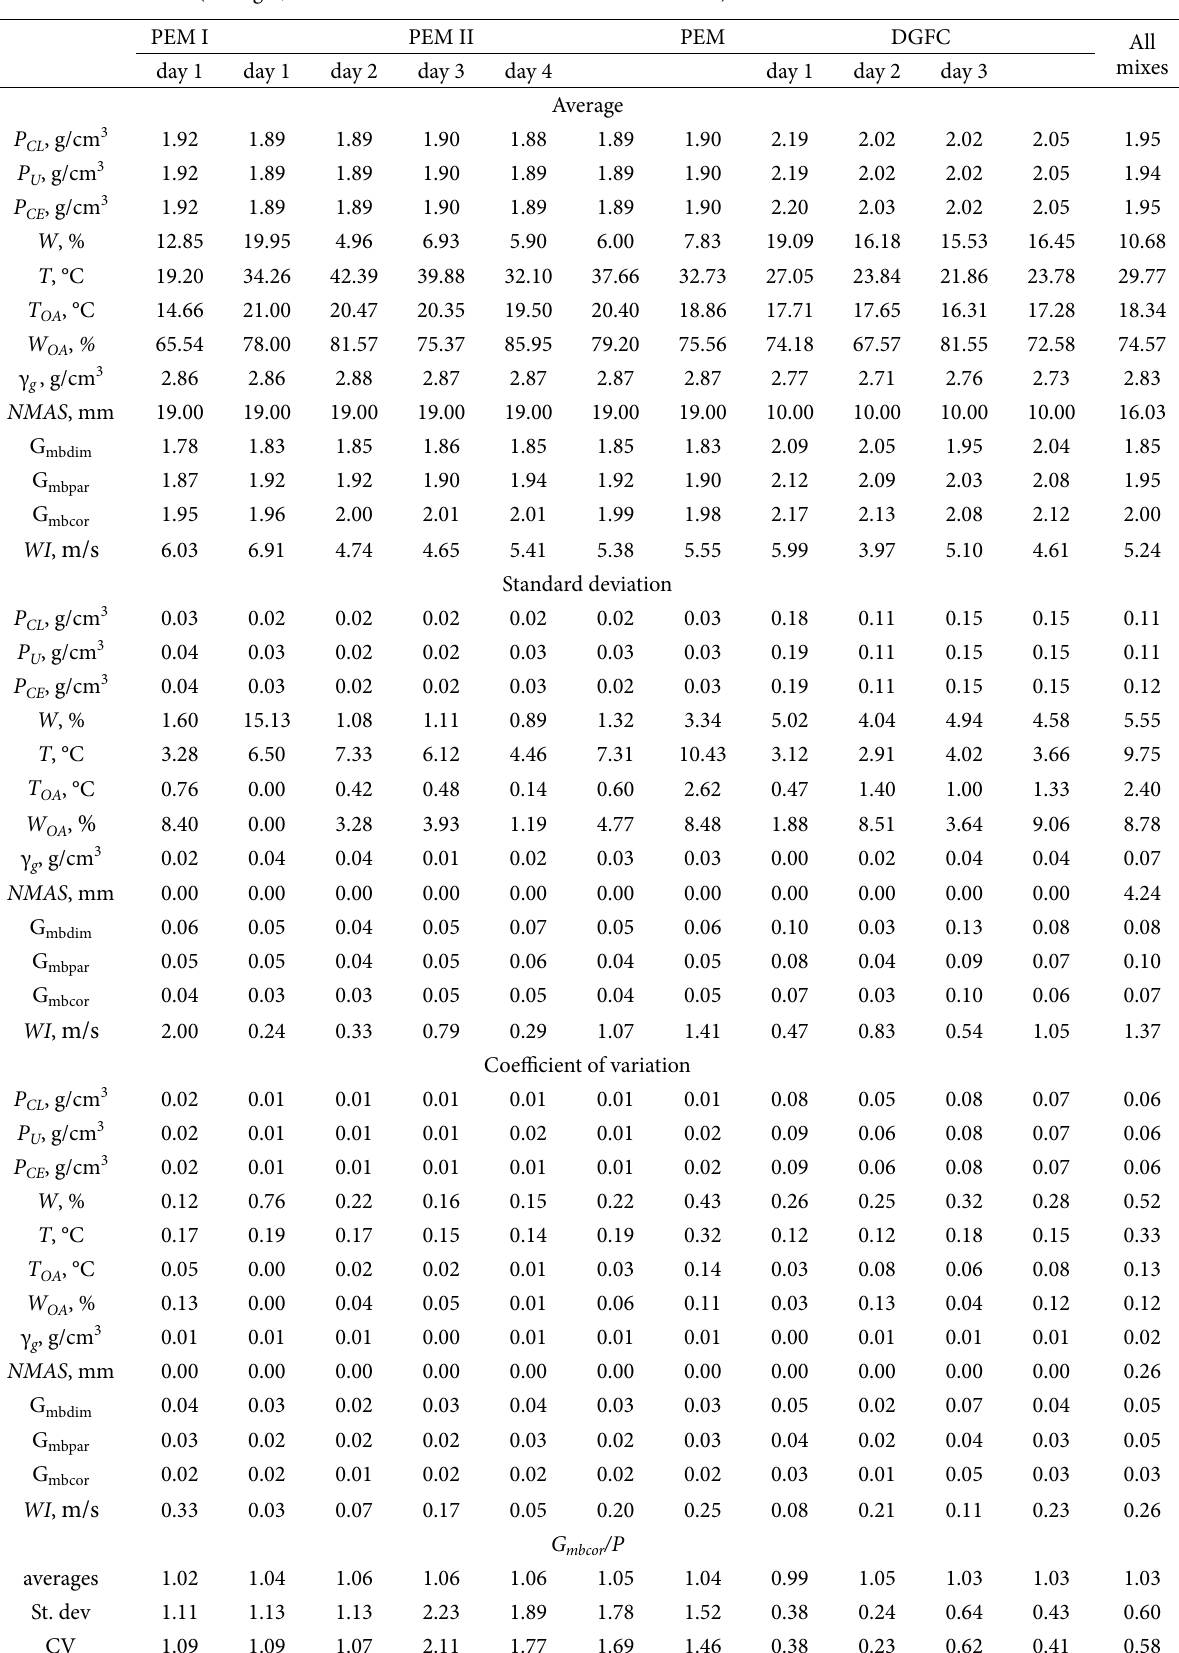
Table 2. Main statistics (averages, standard deviations and coefficient of variations) PEM I PEM II PEM DGFC All mixesday 1 day